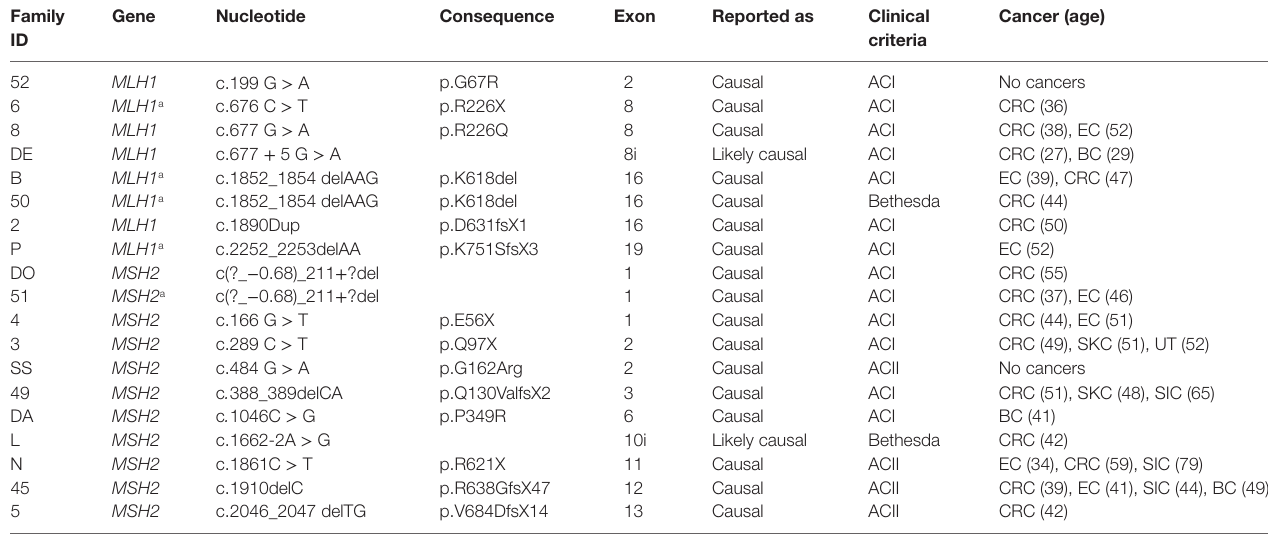
taBLe 1 | Disease-predisposing MMR gene mutations in argentinean Lynch syndrome families. Family ID